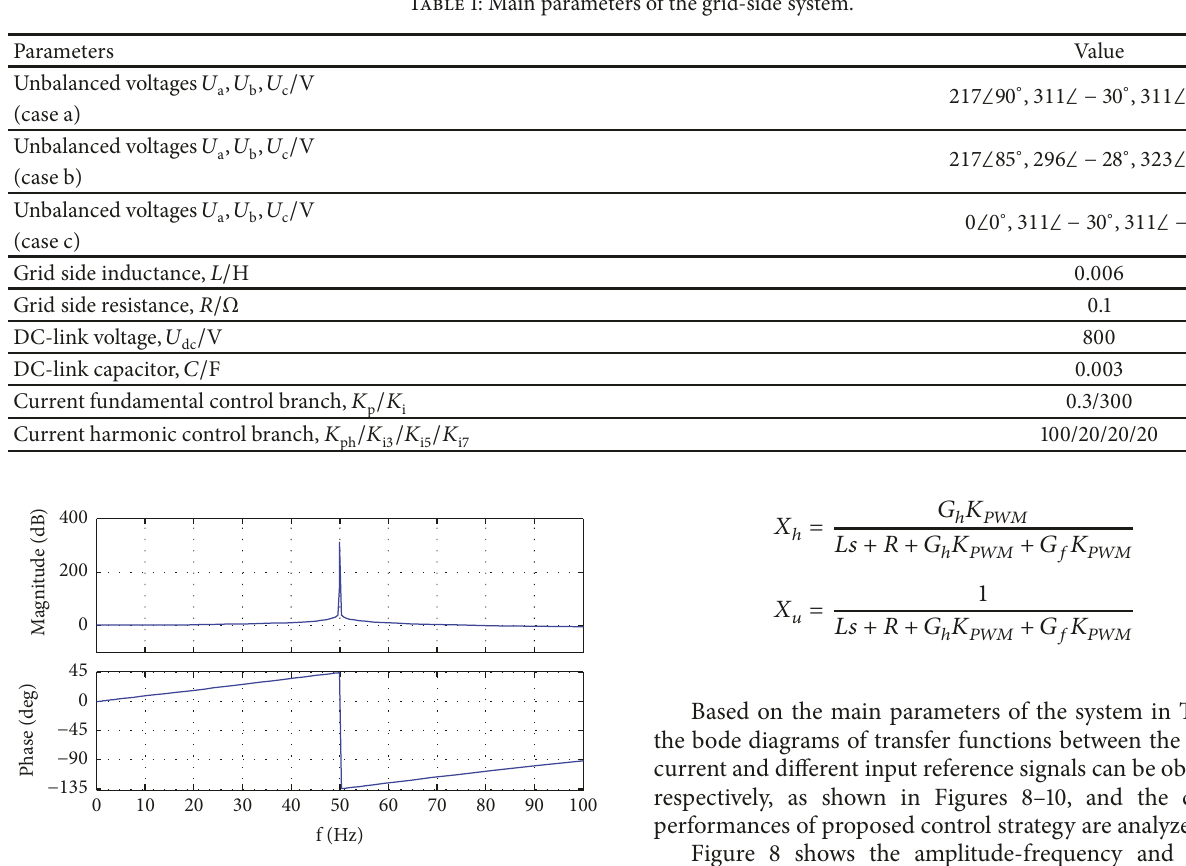
Table 1: Main parameters of the grid-side system.